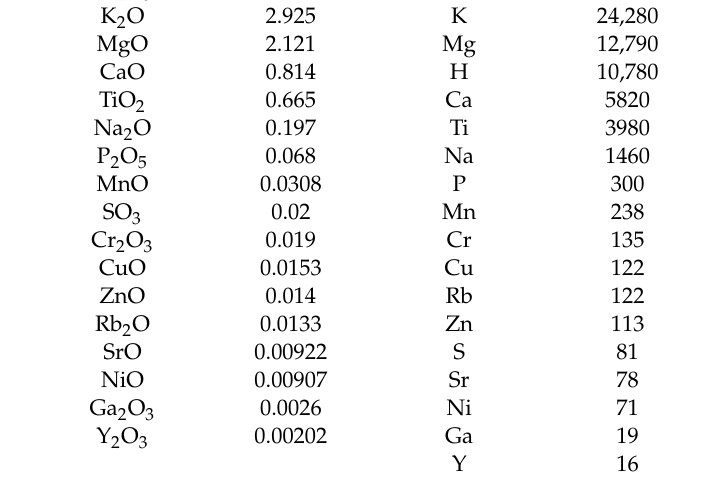
From the XRD (X-ray diffractometry) diagrams, the main mineralogical associations were